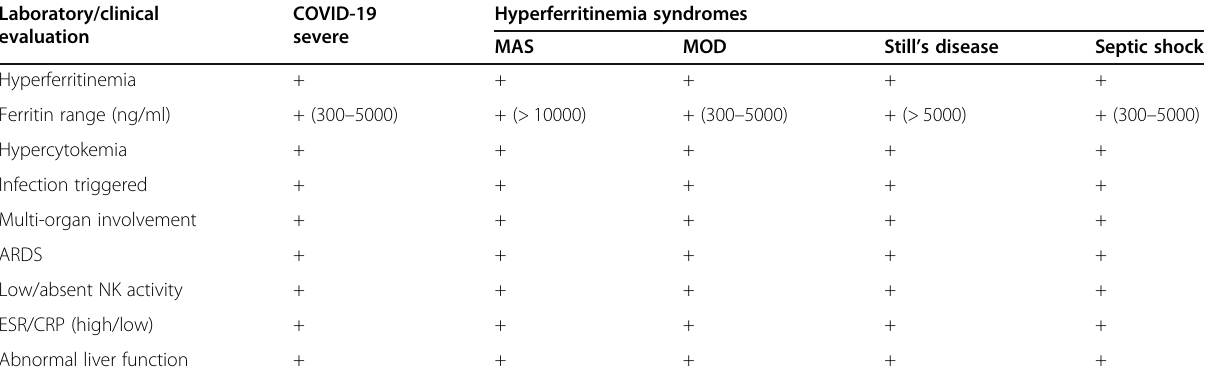
Table 2 Laboratory and clinical abnormalities in COVID-19 and hyperferritinemia-associated syndromes [72] Laboratory/clinical